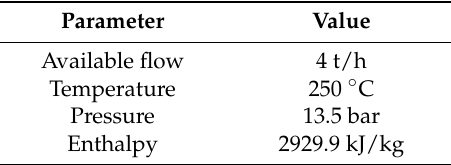
Table 3. Data about the geothermal resource.